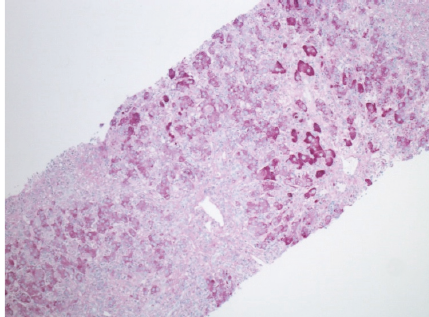
Figure 2: Periodic acid-Schiff stain at 100x magnification demon- strating decreased parenchymal glycogenation. PAS diastase reveals numerous Kupffer cells and portal